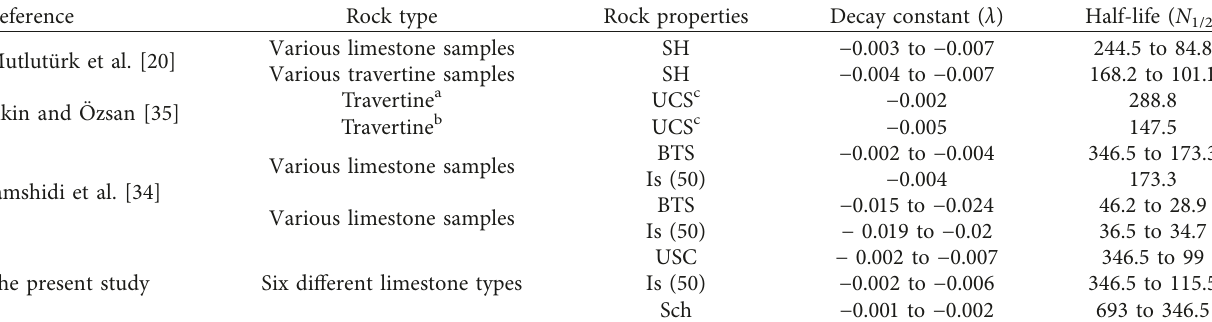
Table 8: Comparing values of the parameters of a mathematical decay function model obtained in the present study with other studies.